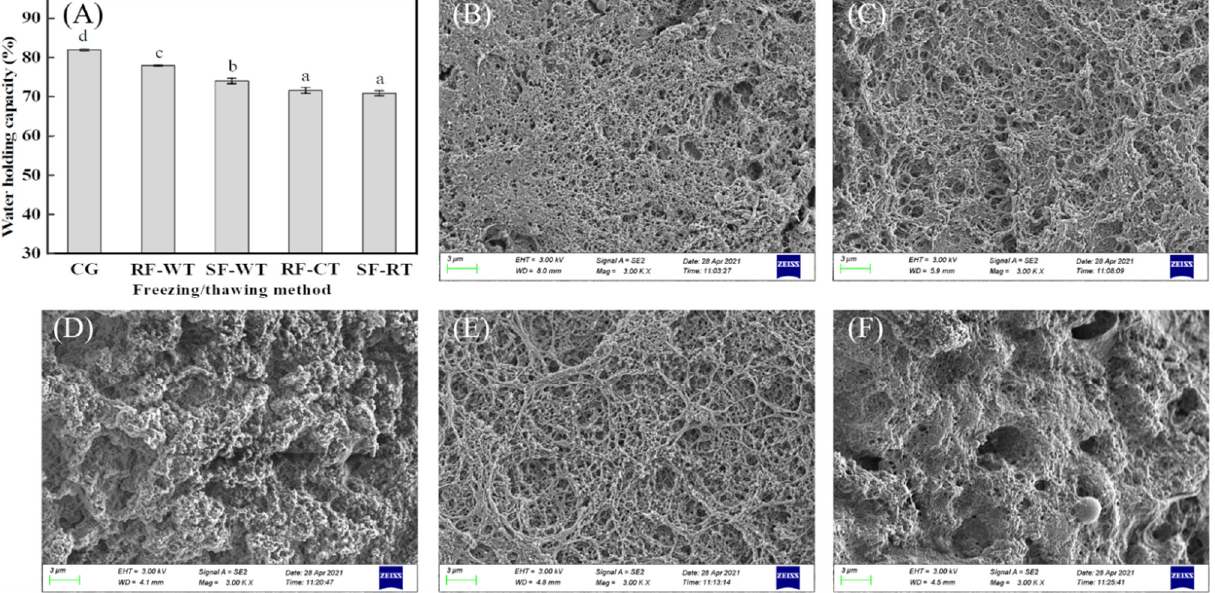
Figure 4. Water-holding capacity ( A ) and scanning electron microscopic images ( B – F ) of heat-induced gels of crayfish meat processed by several freeze-thawing combinations. ( B ): CG; ( C ): RF-WT; ( D ): SF- WT; ( E ): RF-CT; ( F ): SF-CT. CG, control group; RF, rapid freezing; SF, slow freezing; CT, cold thawing; WT, water immersing thawing. Different letters (a–d) in (A) for water-holding capacity indicate significant differences ( p <